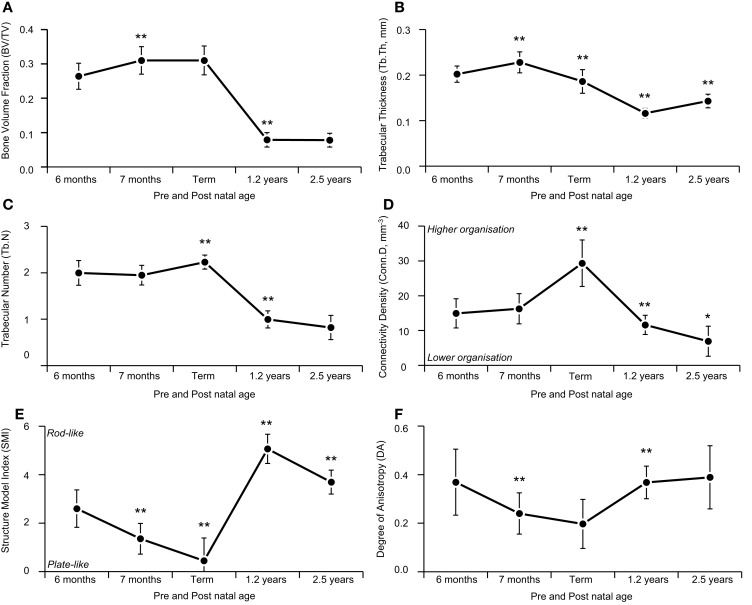
Age-related variation in vertebral trabecular architecture. Asterix denotes significant differences vs. previous age group (*p < 0.05; **p < 0.01). During gestation (6 months-term) there was a steady increase in BV/TV, peaking at term (A). Increasing gestational BV/TV was attributable to increased Tb.N (C) which is also reflected by the increased Conn.D during this time period (D). During infancy (term-1.2 years) vertebrae exhibited a significant decrease in BV/TV (A) due to a reduction in Tb.Th (B) and Tb.N (C), causing trabecula to become more rod like [SMI (E)] and more anisotropic with a dominant inferior-superior axis [DA (F)]. During childhood (1.2–2.5 years) there is an increase in BV/TV (A) and trabecula return to a more, plate like shape [SMI (E)] while structure continues to become more anisotropic, organized along the inferior-superior axis [DA (F)].